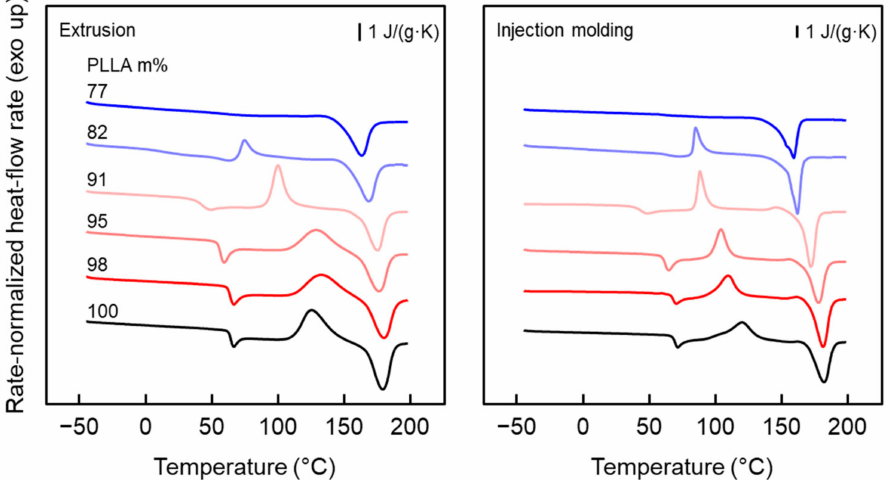
Figure 3. DSC curves: Rate-normalized heat flow rate as a function of temperature for extrudates of neat PLLA and PLLA/IR3535 mixtures ( left ) and injection-molded bars reprocessed from extrudates ( right ) heating at a rate of 20 K/min. Before measurement, samples were stored for 24 days ( left ) and around 4 months ( right ) at room temperature. Note, red and blue color tones are used to indicate glass transition temperatures above and below room temperature,